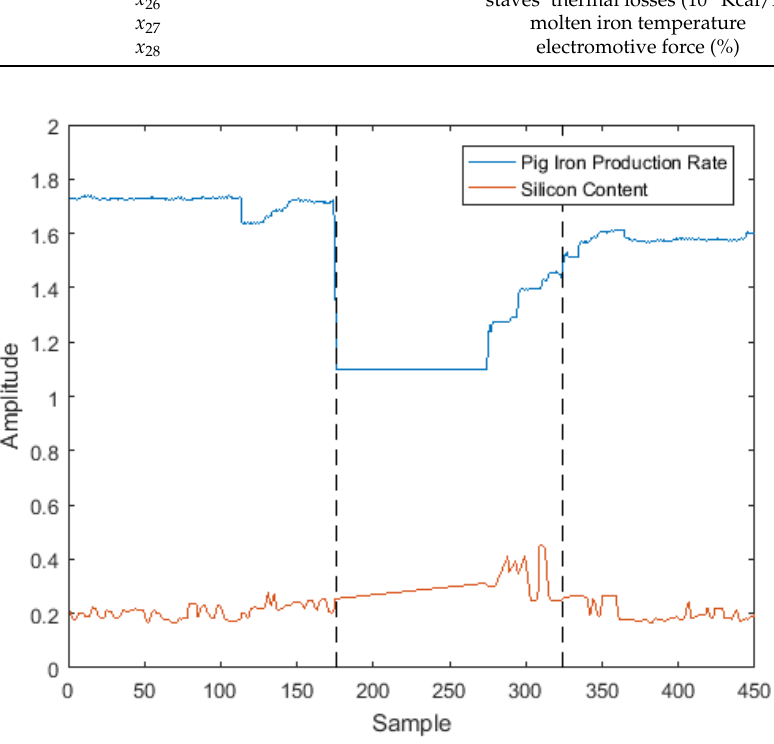
Figure 1. Abnormality period in the blast